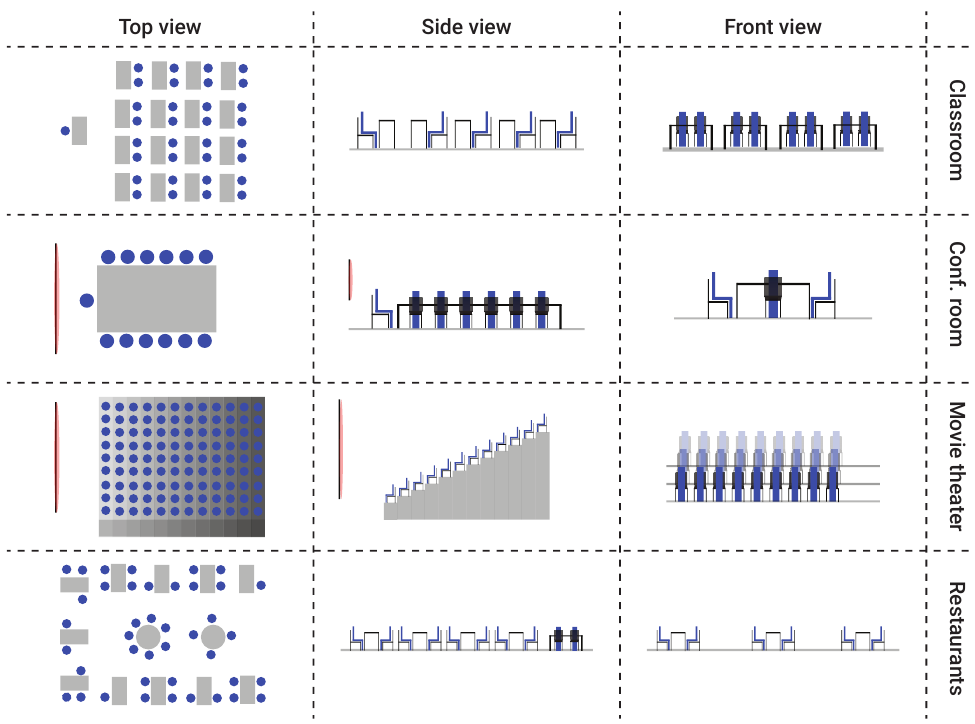
Figure 3. Schematic 3D projection views of the four room types.